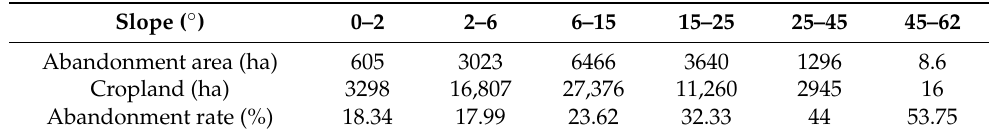
Table 5. Abandonment rate of different slope ranges in Gaolan County.